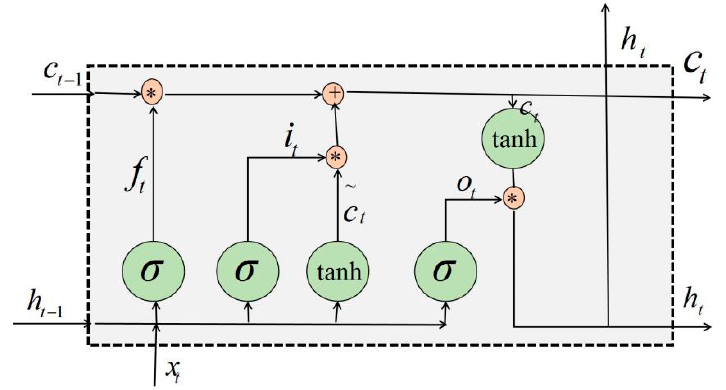
Figure 2. The expanded structure of recurrent neural network (RNN).